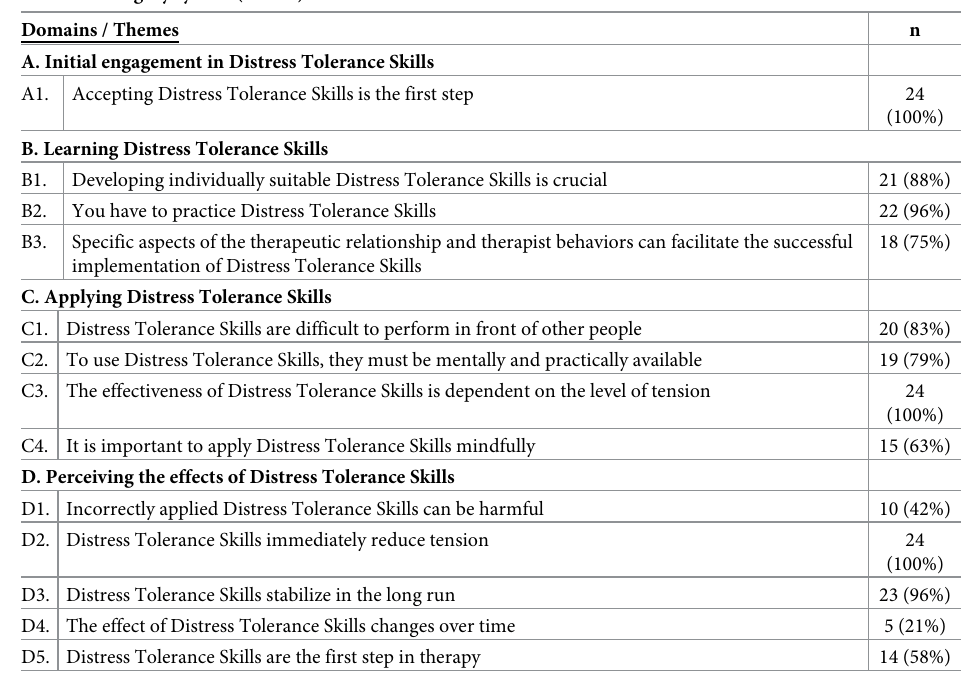
Table 4. Category system (N =